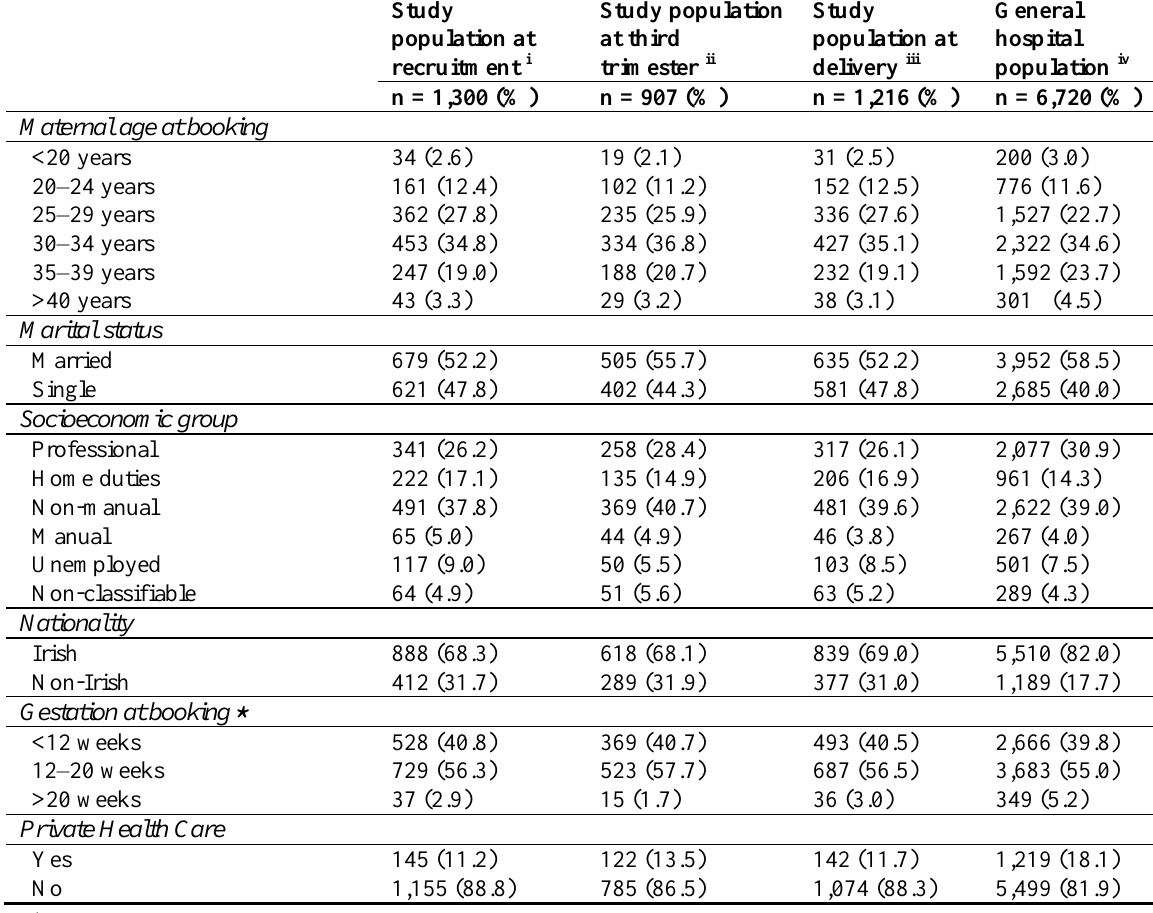
Table 1. Characteristics of Study Cohort in relation to the hospital